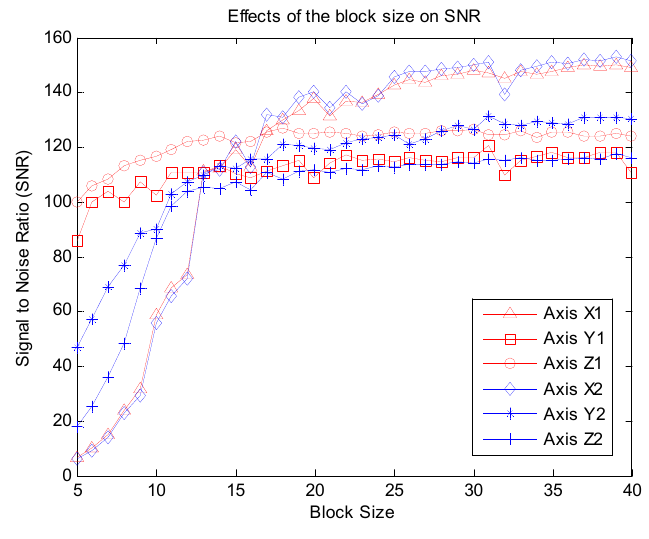
Figure 7. Effects of the block size on SNR.